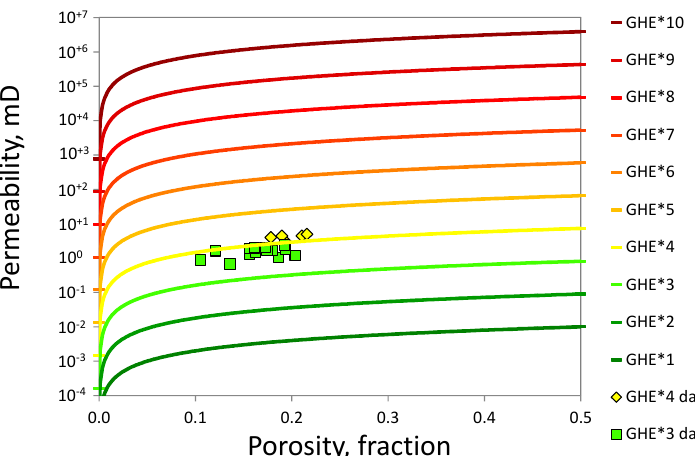
Figure 1. Permeability against porosity for the 19 carbonate rock samples as well as the ten preset classes shown by different GHE* curves. Each line on the template corresponds to a given RQI value and describes the lower boundary of a prebuilt reference GHE* class. As can be seen, the plug samples have been distributed in GHE* classes 3 and 4.